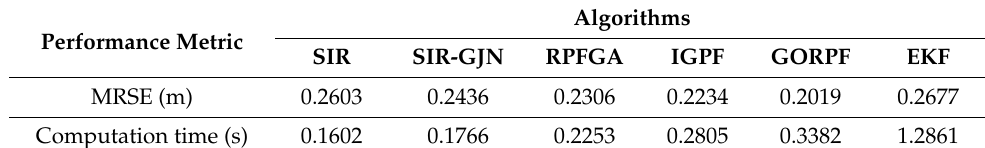
Table 5. The MRSEs (m) and computation time (s) of the six algorithms.